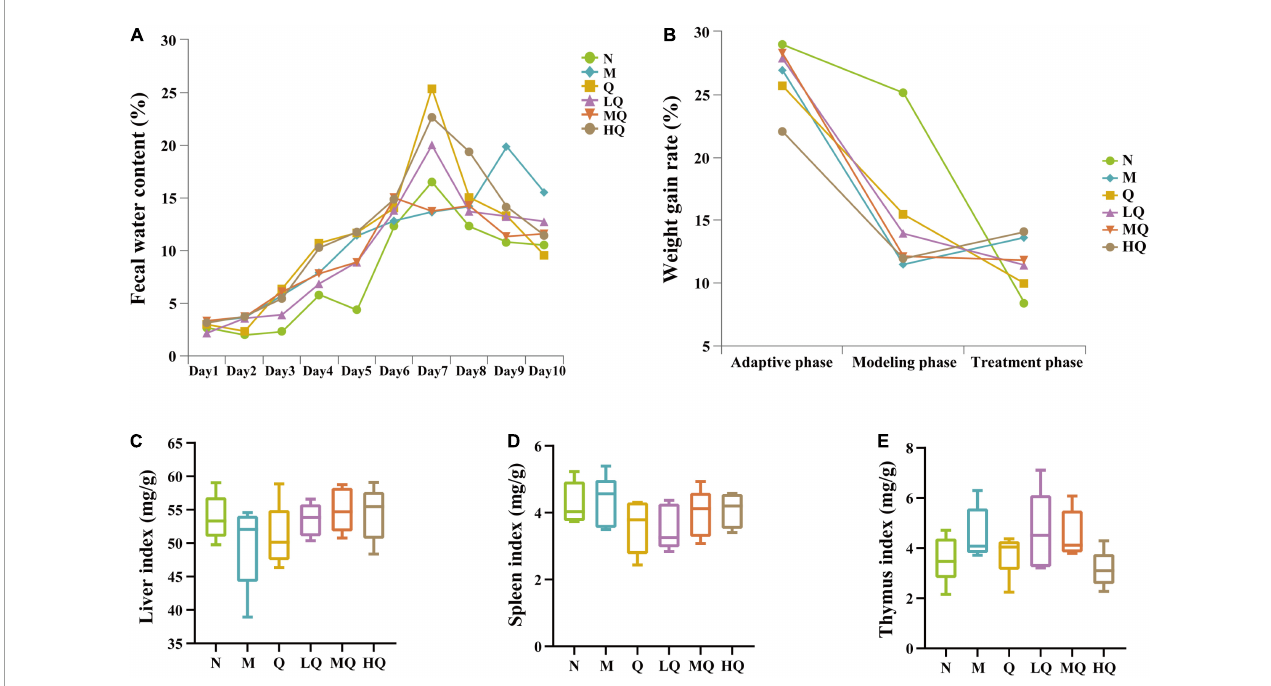
FIGURE2 Effect of antibiotic modeling on normal mice and different sucrose dose on mice with antibiotic-associated diarrhea (AAD) intervened by Qiweibaizhu powder (QWBZP). (A) Fecal water content; (B) Weight gain rate; (C) Liver index; (D) Spleen index; (E) Thymus index.